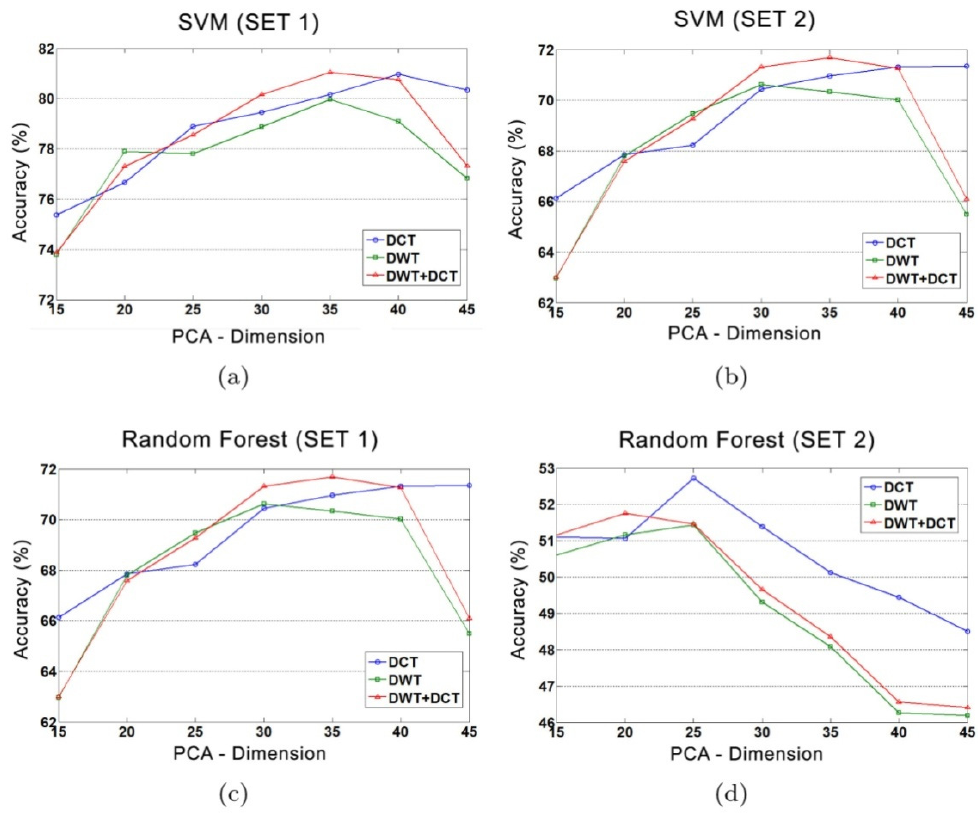
Figure 11. Comparison of accuracy under different sets ( a , b ) show accuracy of SVM with RBF kernel against PCA with different dimensions; ( c , d ) give accuracy of Random Forest against PCA with different dimensions.